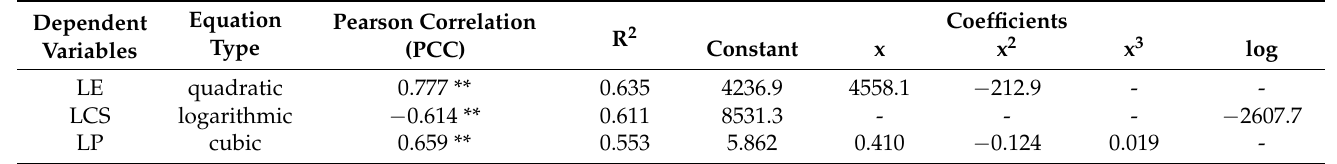
Table 1. Employee satisfaction (ES) as an independent variable in relation to labor expenditure